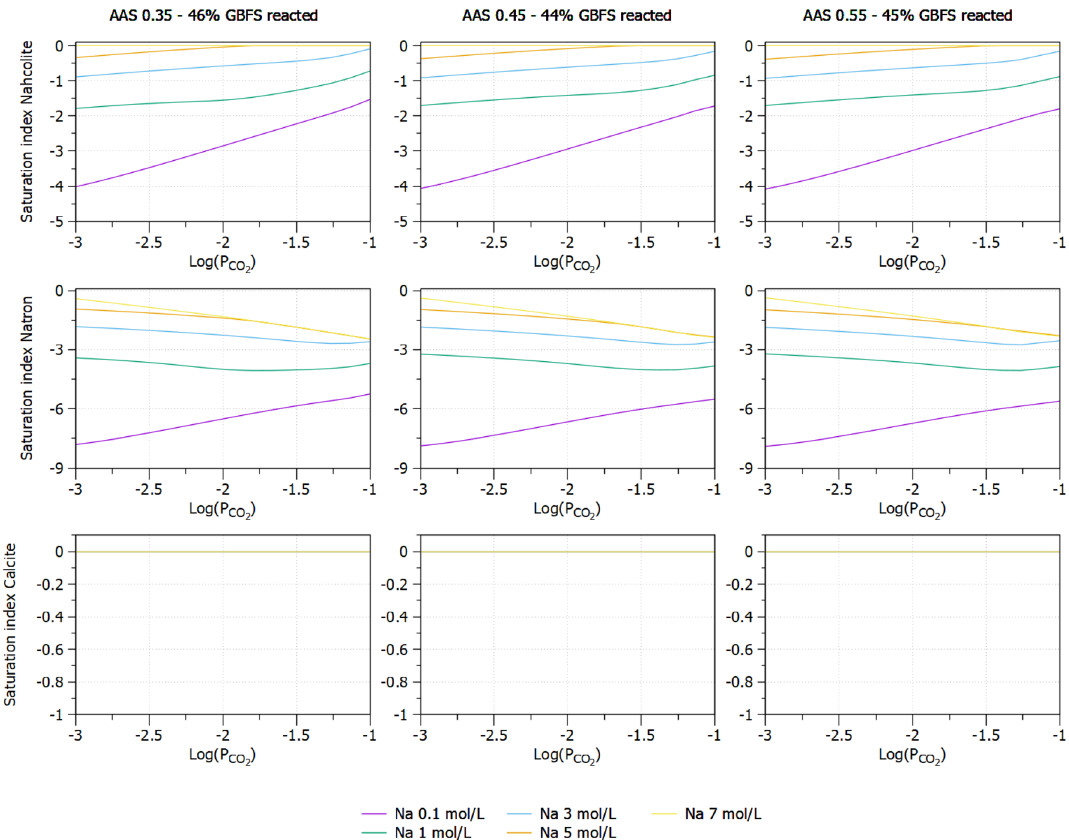
Figure 10. Effect of CO 2 partial pressure on saturation indices of nahcolite (top), natron (middle) and calcite (bottom) of AAS with different w/b